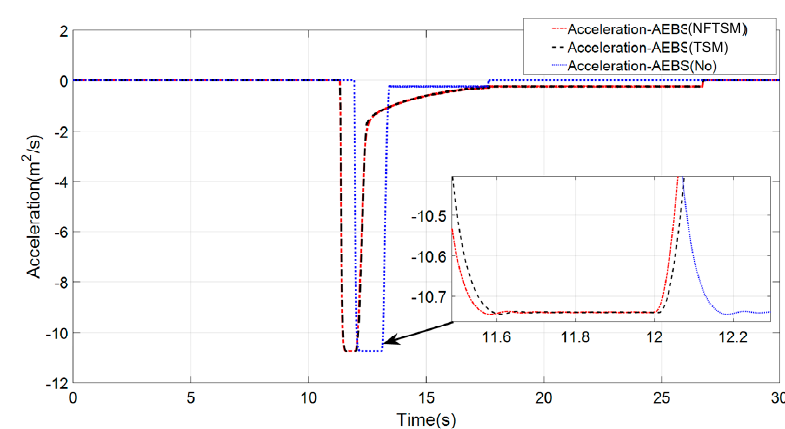
Figure 9. Comparison of relative acceleration.